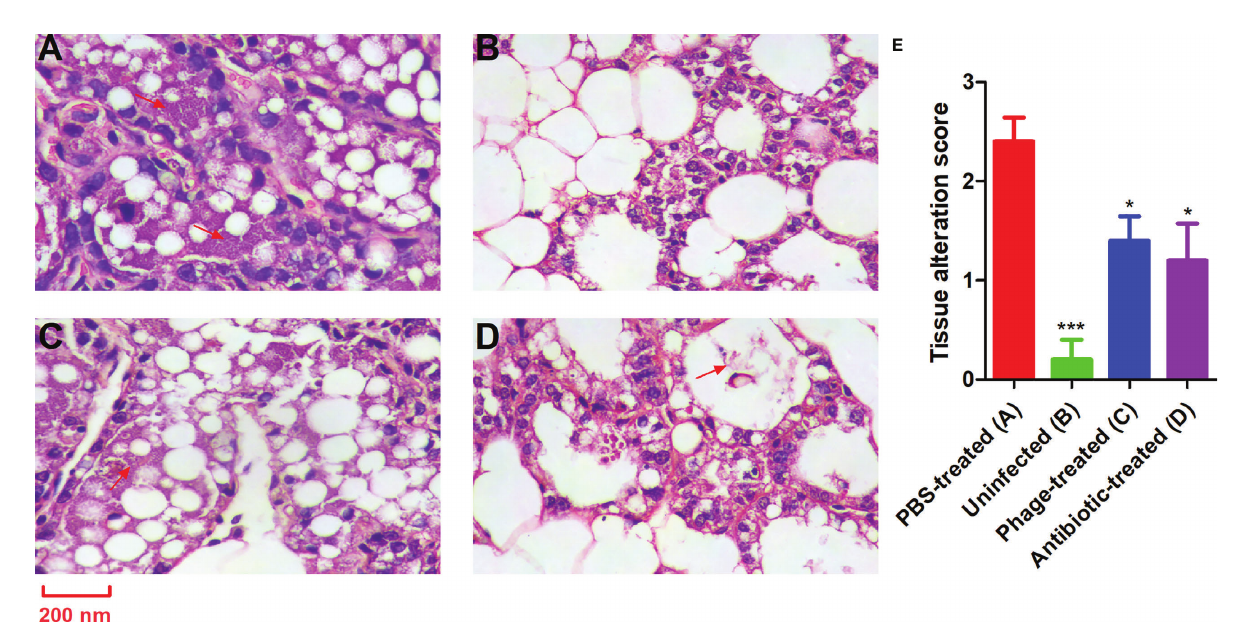
FIGURE 7 | PAJD-1 reduced P. aeruginosa -induced mammary gland lesions of mice. Mice were infected with P. aeruginosa PAmas5 strains and treated with (C) PAJD-1 and (D) ceftiofur sodium. (A) Mice were treated with PBS after infection as a medium-treated group. (B) An uninfected mouse served as a positive control. (E) The tissue alteration score was measured in tissue sections above. The scoring criteria were present in the materials and methods section. Mammary glands were collected 24 h after treatment and processed for H&E staining and microscopic examination. Results are shown as means ± SEM. Asterisks indicate when the tissue alteration score of uninfected mice and mice treated with PAJD-1 or ceftiofur sodium after infection were signi fi cantly lower (*** p < 0.001 and * p < 0.05) than untreated mice after infection. The red arrows indicate neutrophilic in fi ltration. Magni fi cation × 100, scale bars represent 200